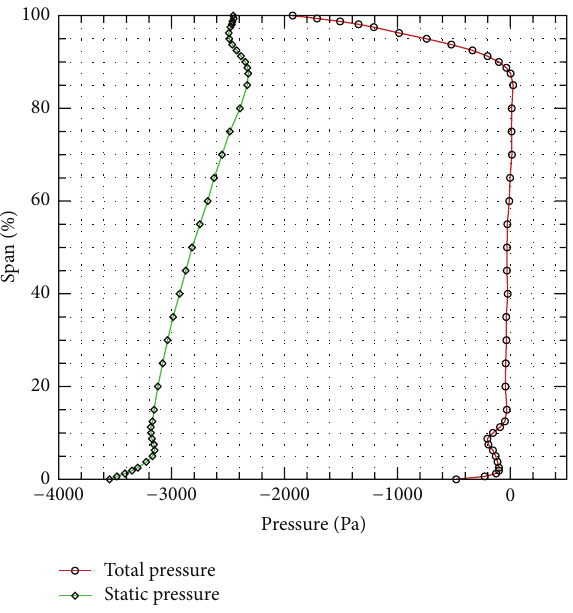
Figure 20: Mass averaged FHP measured total and static pressure,